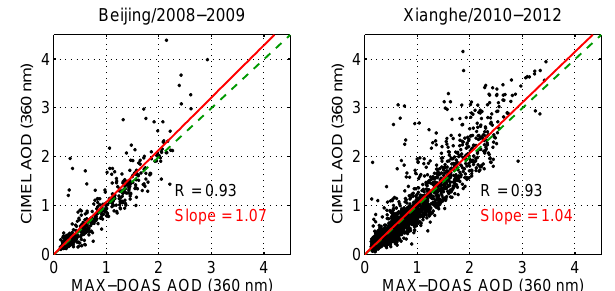
Fig. 6. Scatter plots of the AODs at 360nm retrieved from MAX- DOAS and sunphotometer measurements at Beijing (left plot, Au- gust 2008–April 2009) and Xianghe (right plot, March 2010– December 2012). The linear regressions appear in red and the green dashed lines correspond to the 1 : 1